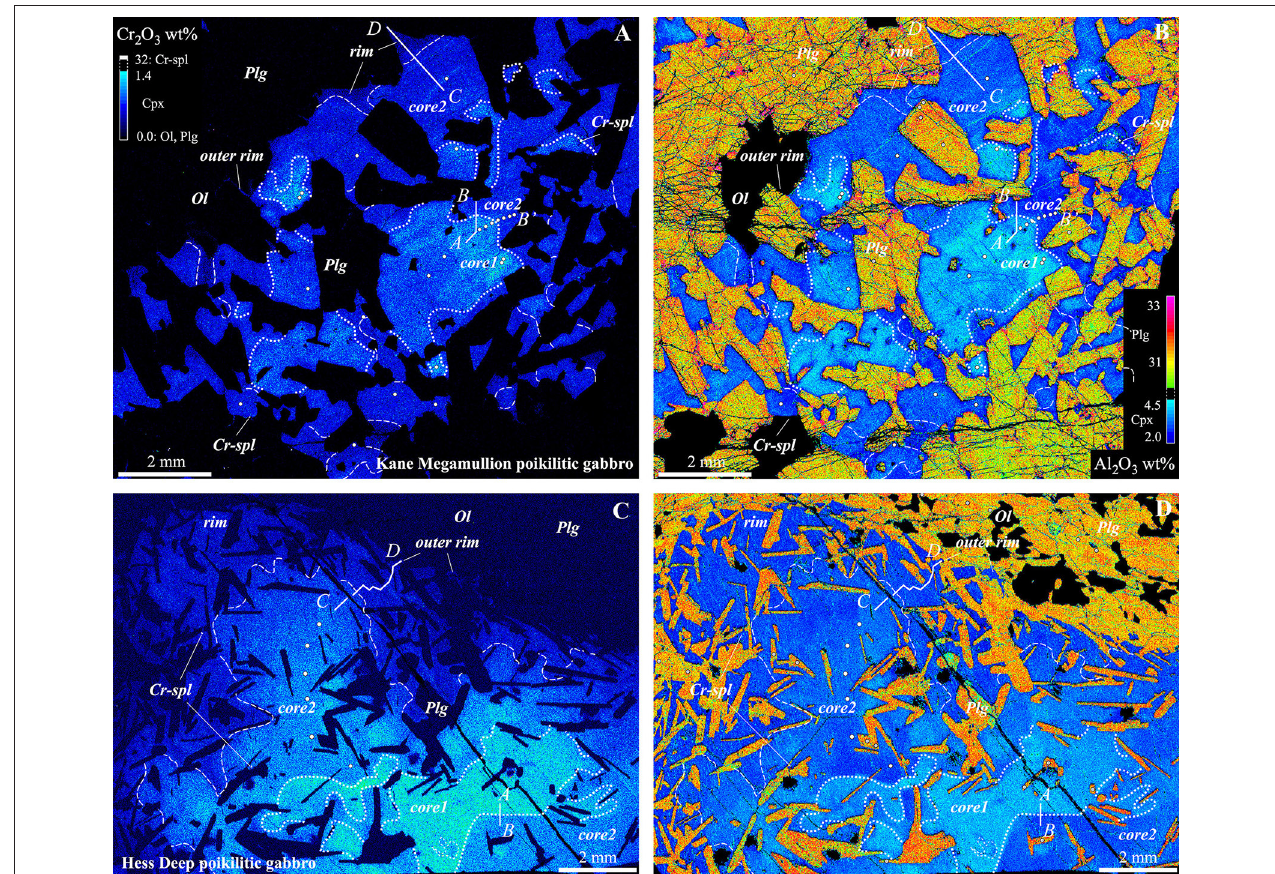
Figure 2 | Complex clinopyroxene microtextures revealed by EMPA X-ray Cr 2 O 3 and Al 2 O 3 maps. See also TiO 2 map in Figure A.3 . (A,B) Kane Megamullion and (C,D) Hess Deep coarse-grained poikilitic gabbro in each case showing a clinopyroxene oikocryst in a clinopyroxene-free groundmass. In both samples, early formed core1 shows resorption texture and subsequent crystallization of chemically distinct clinopyroxene core2 and rim oikocrysts. Gray dots are isolated EMPA and LA-ICP-MS analyses, completing core1-core2 profile (A,B [B’]) and core2-rim-outer rim profile (C,D).